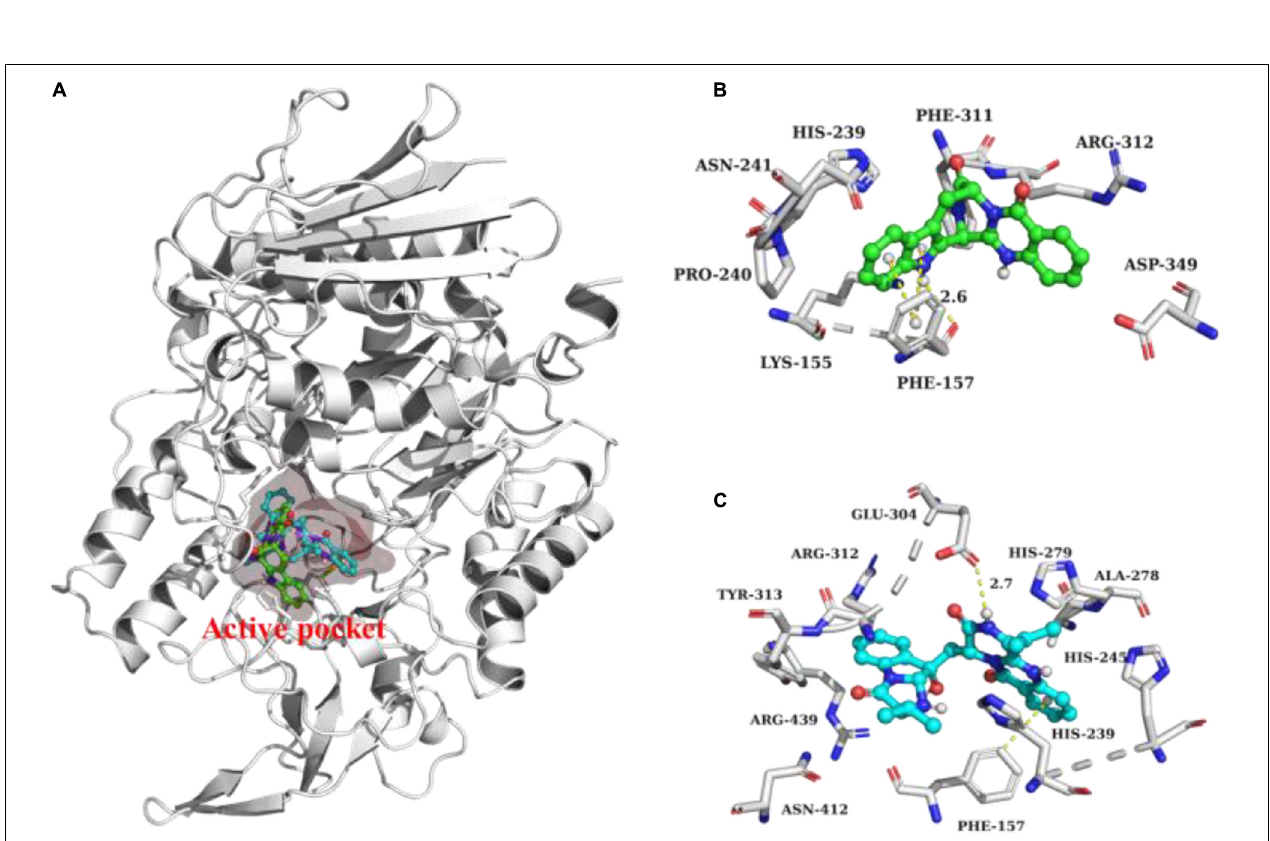
FIGURE 5 | Docking analysis of 10 (green ball and stick) and 16 (cyan ball and stick) with α -glucosidase (A) . 3D cartoon diagram of the interactions of 10 (B) and 16 (C) with α -glucosidase.